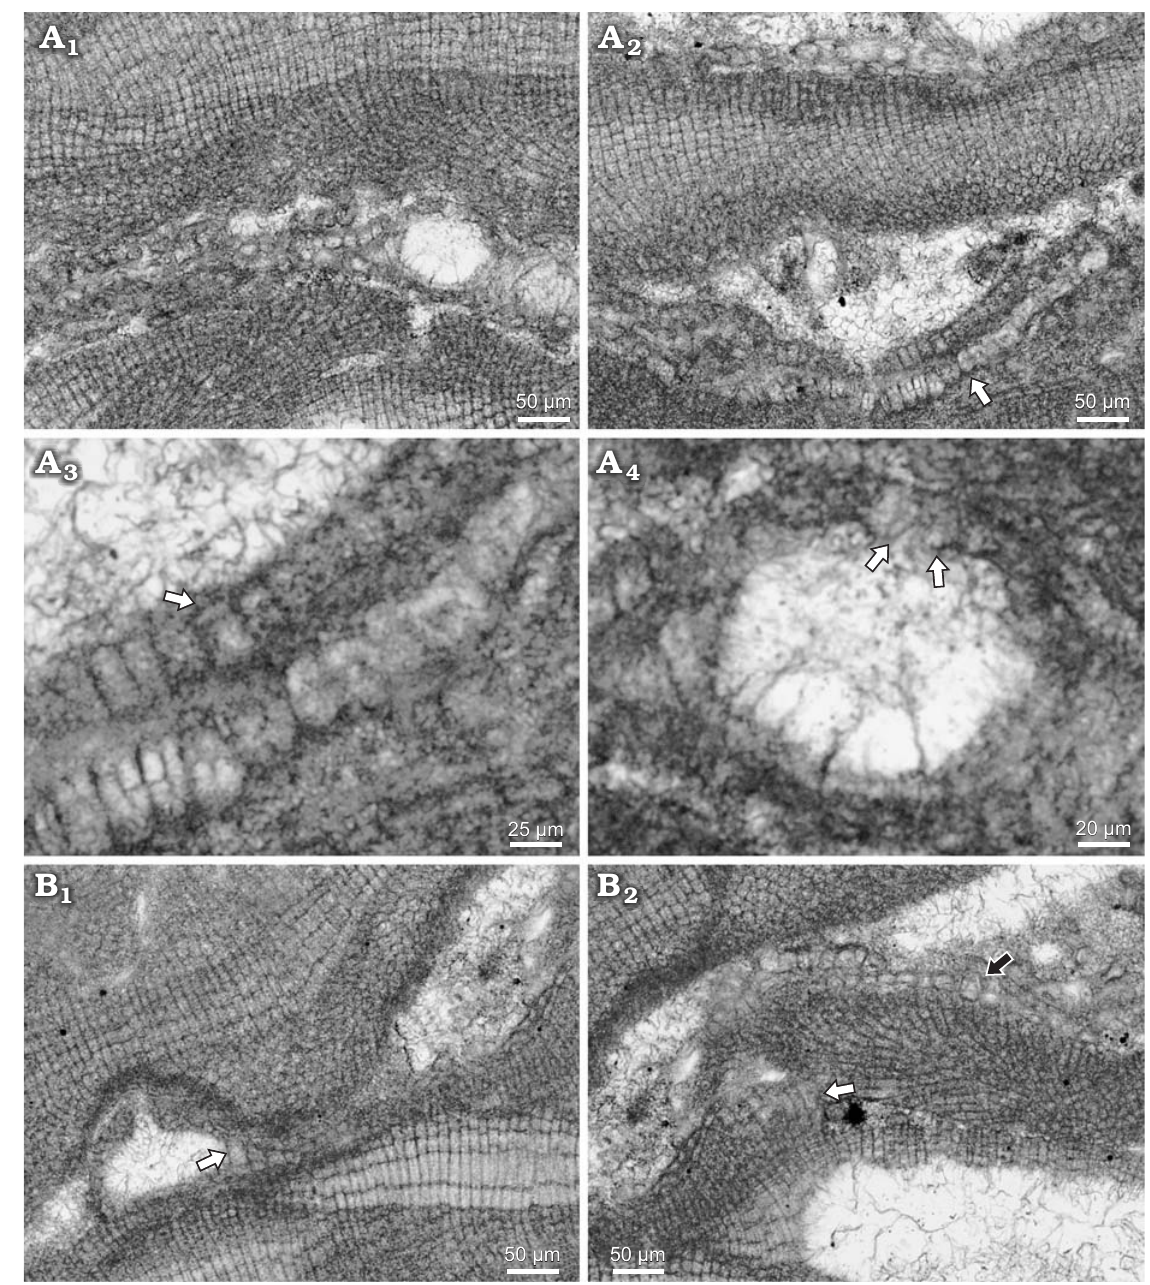
Fig. 6. Lithoporella minus Johnson, 1964 from early Serravallian, Rohožník, Slovakia, Vienna Basin. A . Bi/tetrasporophyte, NHM B1850/1 (thin sec- tion 5099). A 1 . Plant with encrusting growth form and conceptacles projecting above thallus surface. Thallus is entirely bi-stratose. A 2 . Palisade cells in primigenous filament developed in patches and non-palisade cells are present as well (arrow). A 3 . Arrow points to flattened not flared epithallial cell; note cell fusions in lower thallus. A 4 . Enlarged A 1 . Uniporate conceptacle with preserved pore canal cells (arrows). Cells are narrower and elongated. B . Gametangial-carposporangial plant, NHM B1850/2 (thin section 5099). B 1 . Projection of the conceptacle above thallus surface; arrow points to the single trichocyte at the side of the conceptacle. B 2 . Single trichocyte in distant portion of the thallus (black arrow); white arrow points to the palisade